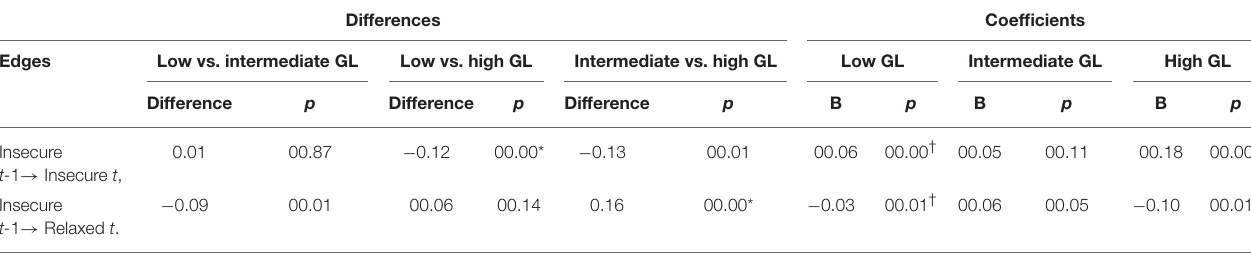
TABLE 5 | Significant edge differences across different levels of GL.